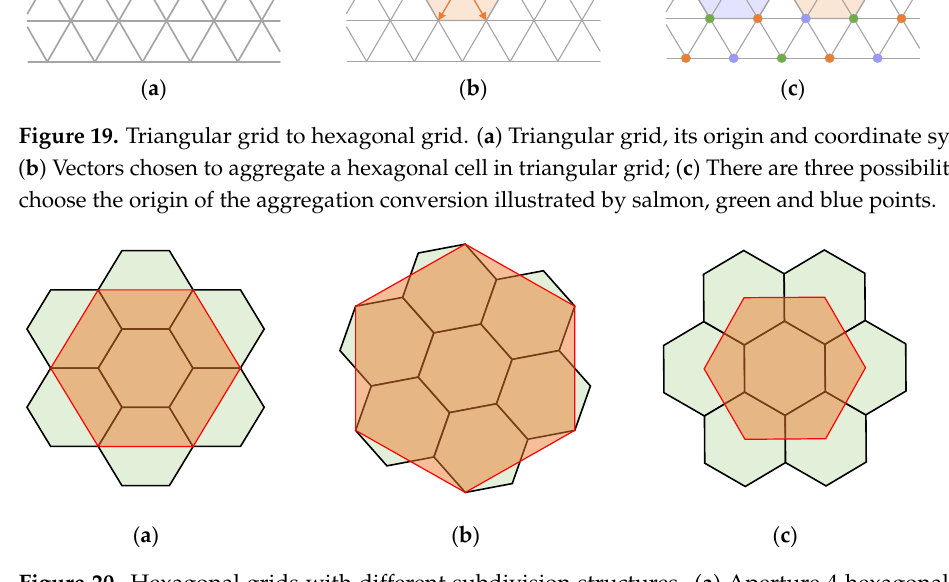
Figure 20. Hexagonal grids with different subdivision structures. ( a ) Aperture 4 hexagonal grid; ( b ) Aperture 7 hexagonal grid; ( c ) Aperture 3 hexagonal grid.